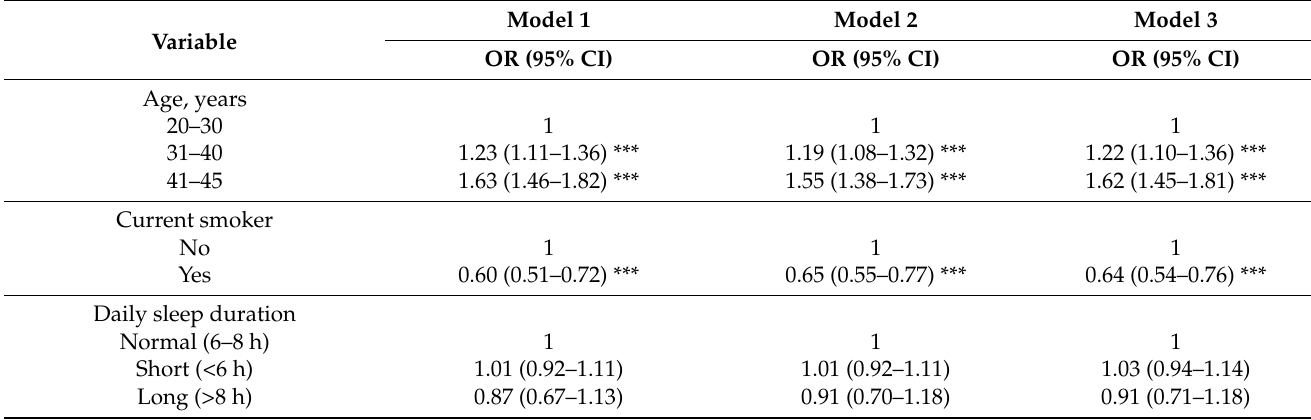
Table 2. Association between lifestyle, anthropometric, or dietary variables and the presence